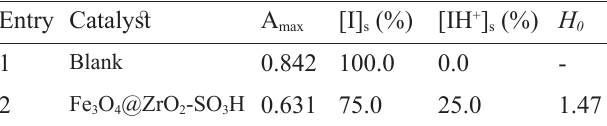
Table 3. Calculation of Hammett acidity function ( H 0 ) of Fe 3 O 4 @ ZrO 2 -SO 3 H.